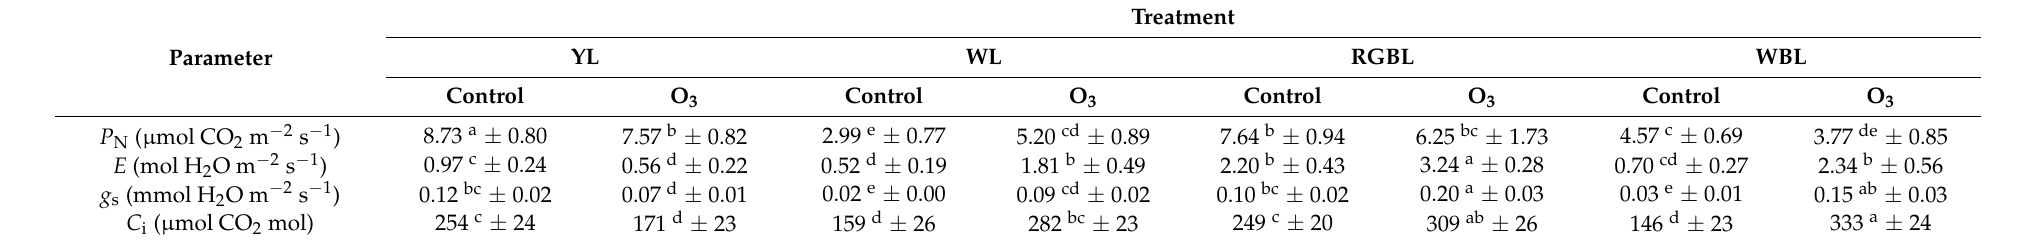
Table 2. Gas exchange parameters of Brassica rapa subsp. pekinensis growing in a different light spectrum and treated with ozone (100 ppb, 21 days) or non-fumigated (control). YL—yellow light (sodium lamp), WL—white light (LED), RGBL—red + green + blue light (LED) and WBL—white + blue light. Average values ( ± SD) marked with the same letters in the row do not differ significantly according to Duncan’s test, p ≤ 0.05, n =